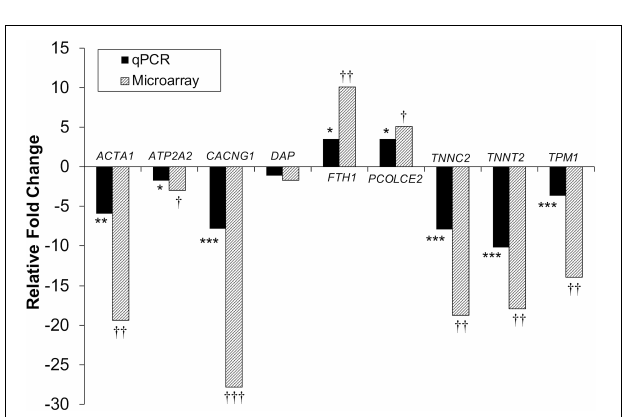
FIGURE 4 | Microarray and qPCR data show similar trends of expression differences in differentiation experiments. Fold change is described as change in gene expression in the DAP knockdown samples relative to controls. Bars below the origin indicate lower expression (down-regulation) of the gene in the DAP knockdown samples; bars above the origin indicate higher expression (up-regulation). * P < 0.05, ** P < 0.01, *** P < 0.001, † FDR < 0.05, †† FDR < 0.01, and ††† FDR < 0.001. ACTA1 , actin alpha 1 skeletal; ATP2A2 , sarcoplasmic/endoplasmic reticulum ATPase 2 cardiac; CACNG1 , voltage dependent calcium channel gamma 1; DAP , death-associated protein; FTH1 , ferritin heavy polypeptide 1; PCOLCE2 , procollagen C-endopeptidase enhancer; TNNC2 , Troponin C type 2 fast skeletal; TNNT2 , Troponin T type 2 cardiac; TPM1 , Tropomyosin